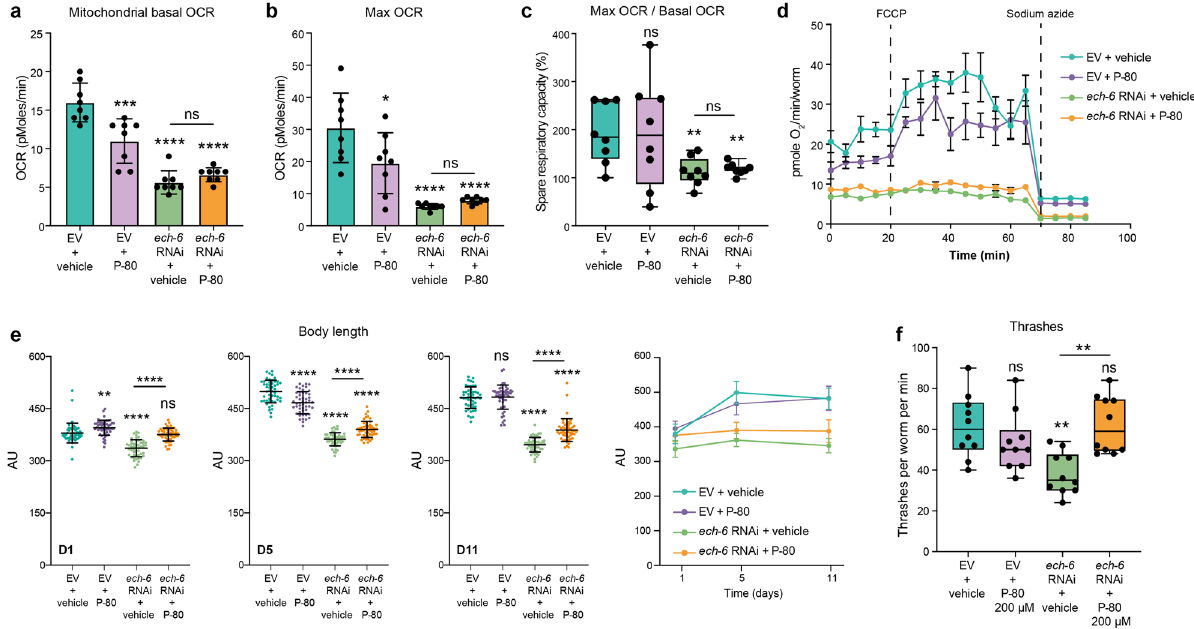
Figure 3. RNAi of ech-6 suppresses metabolic activity, mobility, and growth. ( a , b ) Mitochondrial basal and maximum oxygen consumption rate (OCR) in adult N2 worms at day 5 of adulthood. P-80 supplementation and ech-6 RNAi decrease mitochondrial respiration rate at both the basal (A) and the maximal levels (B). Mean ± SD of n = 8 biological replicates. ( c ) Mitochondrial spare respiratory capacity in percentage. ( d ) Raw averaged traces of oxygen consumption from day 5 adult N2 worms. Mean ± SEM (n = 8); FCCP, an uncoupler reagent, was added at the indicated time to achieve the maximum mitochondrial respiration, while sodium azide, a complex IV inhibitor, was added to fully block mitochondrial respiration, thereby measuring non-mitochondrial oxygen consumption. ( e ) Body length of N2 worms at day 1, day 5 and day11 of adulthood, respectively. Mean ± SD of n = 50 animals. P-80 supplementation ameliorates ech-6 RNAi-mediated growth inhibition in three age groups of worms examined. ( f ) Thrashing of N2 worms at day 2 of adulthood exposed to ech-6 RNAi and 200 µM P-80 diet, individually or in combination. P-80 supplementation to ech-6 -deficient worms restores movement ability, measured by the frequency of thrashes per worm per minute. Mean ± SD of n = 10 animals. The bar graphs depict mean ± SD. An asterisk directly above a box refers to statistical significance compared to empty vector (EV)-treated wild-type fed a regular NGM diet. ** p < 0.01; *** p < 0.001; **** p < 0.0001; ns, not significant; one- way ANOVA, Holm-Sidak